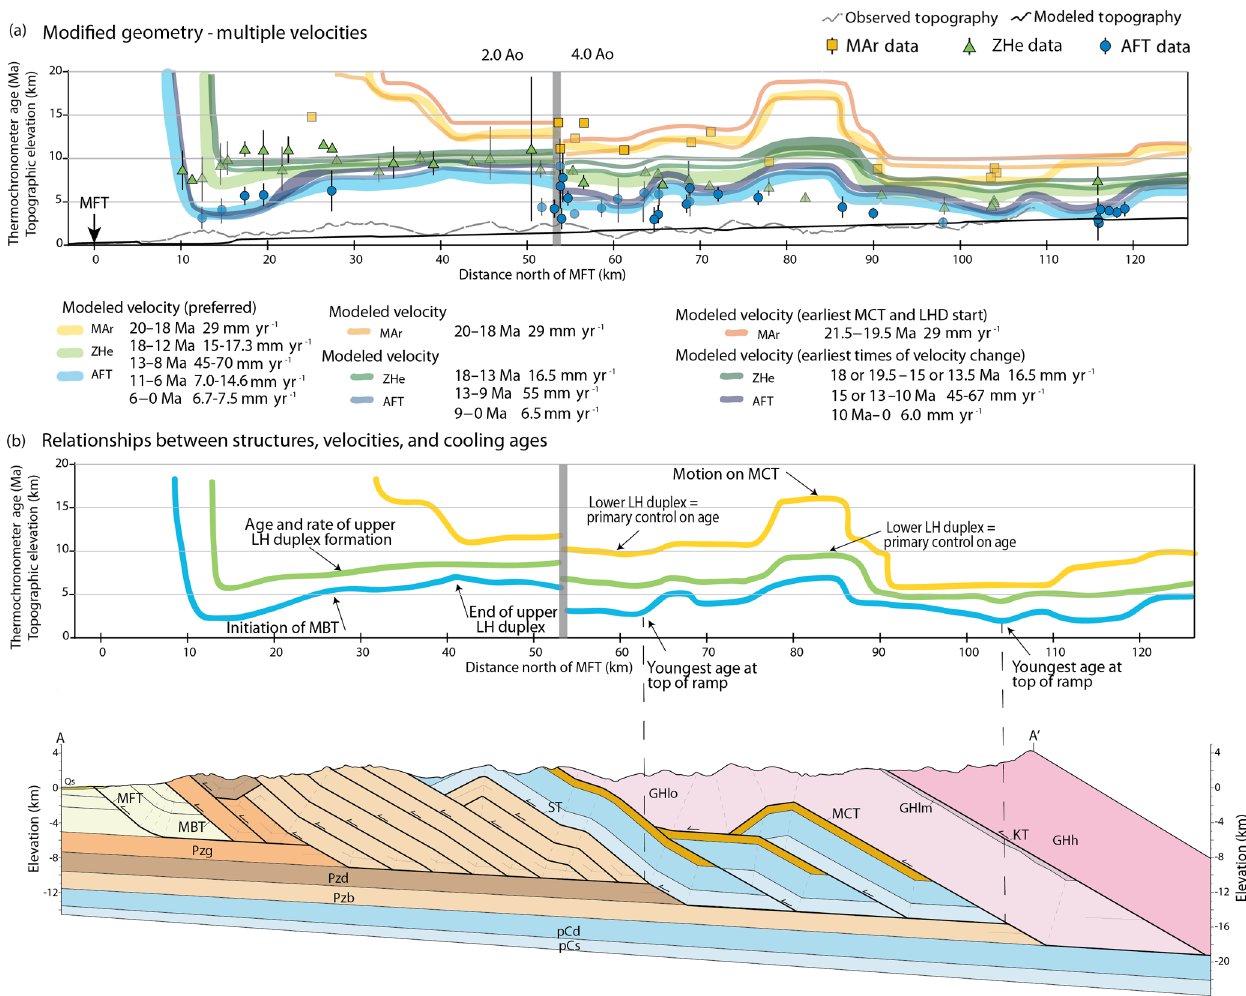
Figure 11. (a) Predicted MAr (yellow), ZHe (green), and AFT (blue) cooling ages for velocities tested using the modified Trashigang cross section geometry. Published data include additional ages from the Kuru Chu line of section 30km west of the Trashigang section (Long et al., 2012), which are indicated by transparent thermochronometer symbols. Predicted ages are presented with combined thermal models using A 0 of 2.0 and 4.0µWm − 3 . Flexural–kinematic models used Split KT and responsive topography. (b) Relationships between structures, velocities, and predicted cooling